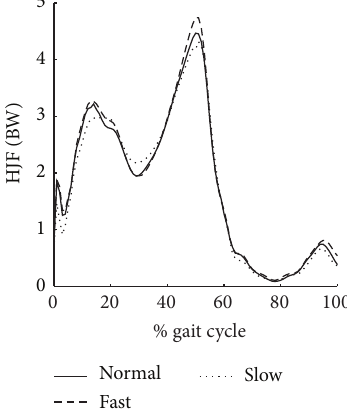
Figure 3: Mean ensemble curves of the resultant hip joint force (HJF) during the gait cycle. Solid line represents the normal walking condition, dashed line represents the fast walking condition, and dotted line represents the slow walking